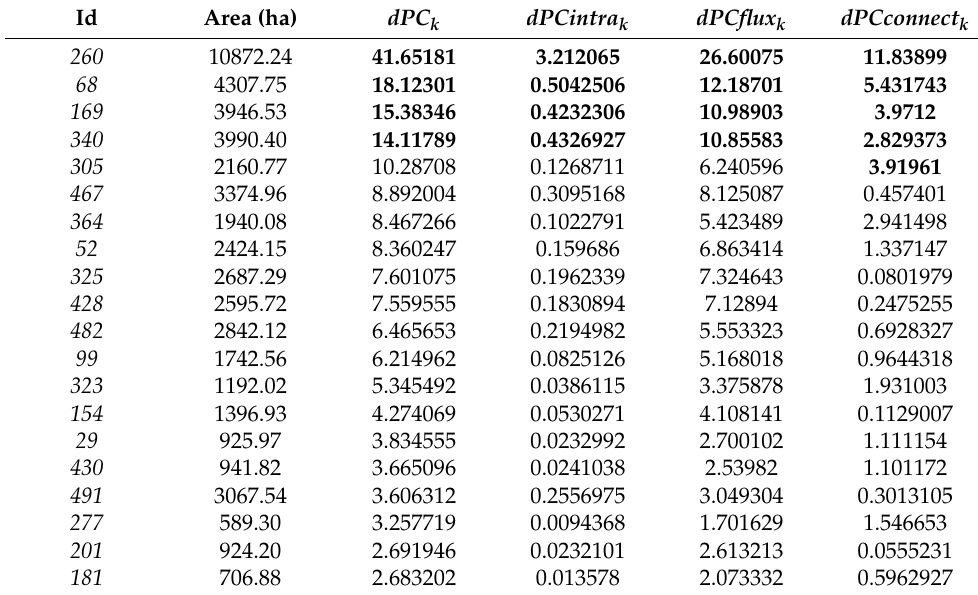
Table 3. The oak forest patches with the largest contribution to connectivity in the Cuitzeo Lake